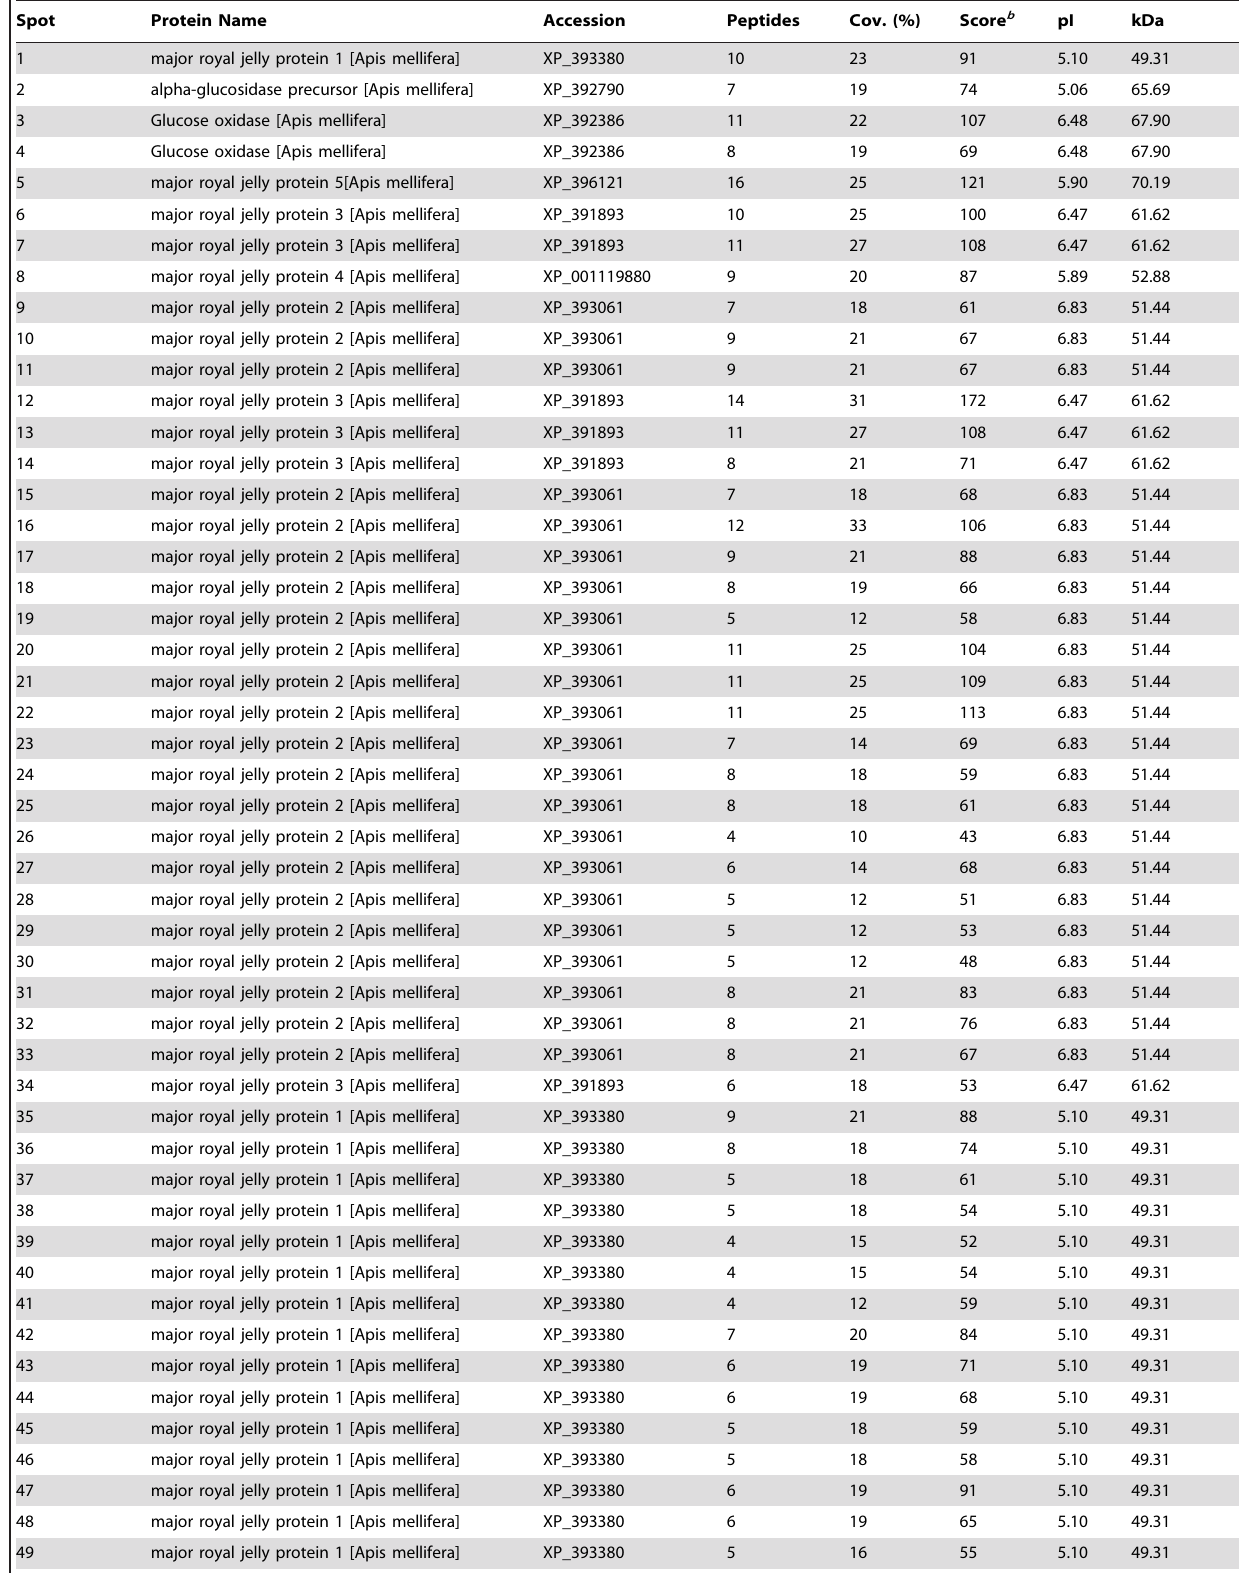
Table 2. Protein identification in the honey orange MT1 extract a